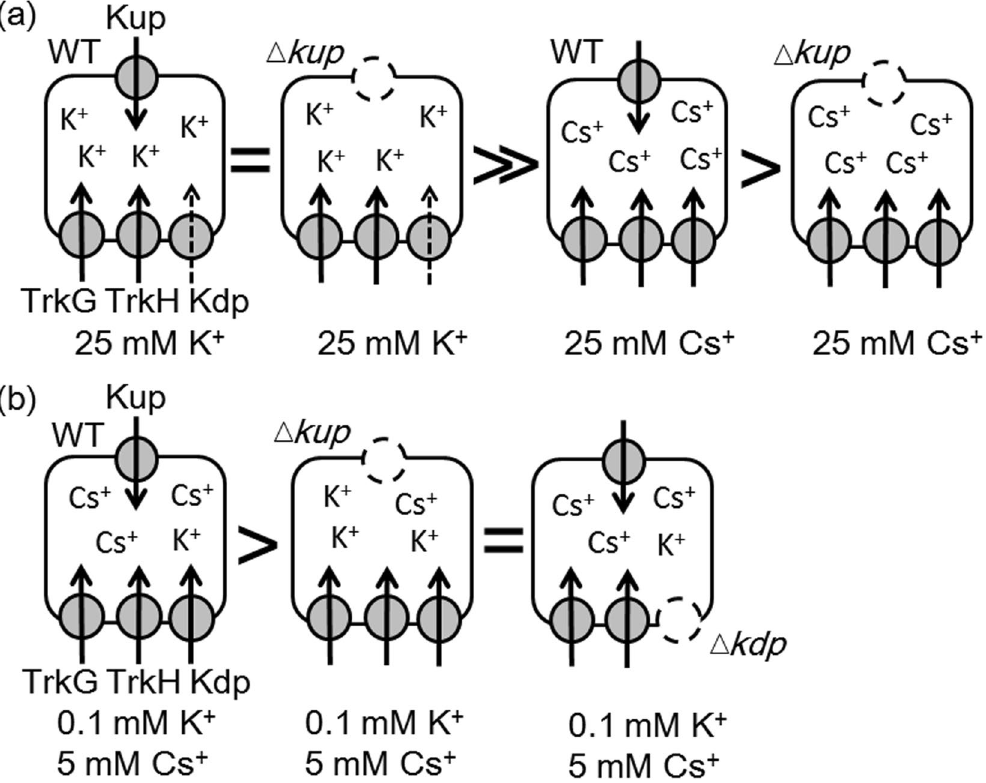
Figure 7. Model explaining the coordinated activity of Kup with the K + uptake transporters Kdp and Trk in response to excess Cs + in E . coli . ( a ) Kup-mediated Cs + uptake contributed to growth of E . coli WT in medium containing Cs + as the only alkaline metal. Under sufficient K + conditions, loss of Kup had no effect on growth. Contribution of high affinity Kdp uptake system may be small at high K + and their expression may be suppressed at high K + 31, 38 . ( b ) As long as a low concentration of K + was present, the WT was able to grow even with high amounts of Cs + . ( c ) K + uptake by other K + uptake transporters (Kdp, TrkG and TrkH) was important for the growth of E . coli in the presence of high Cs + . = , >> , > indicates equal, much higher and higher